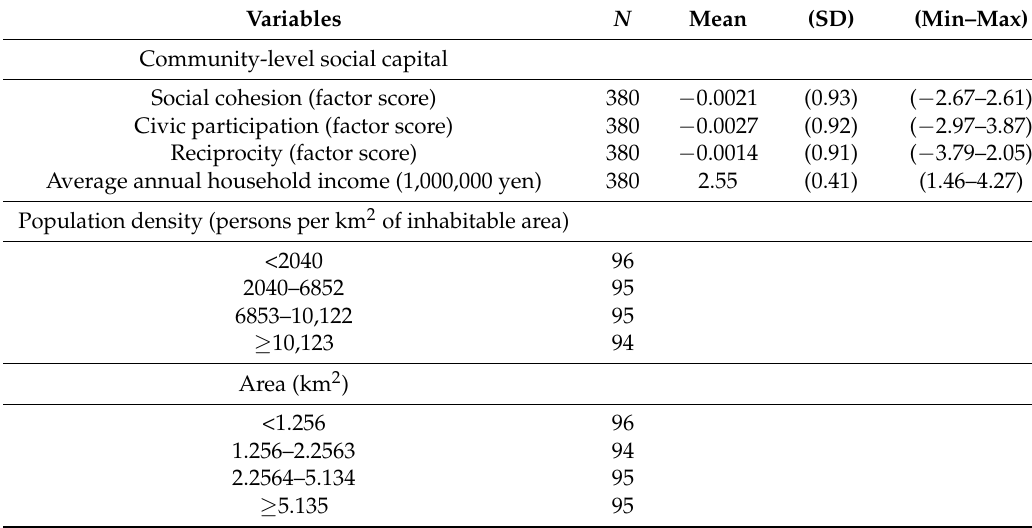
Table 3. Characteristics of community